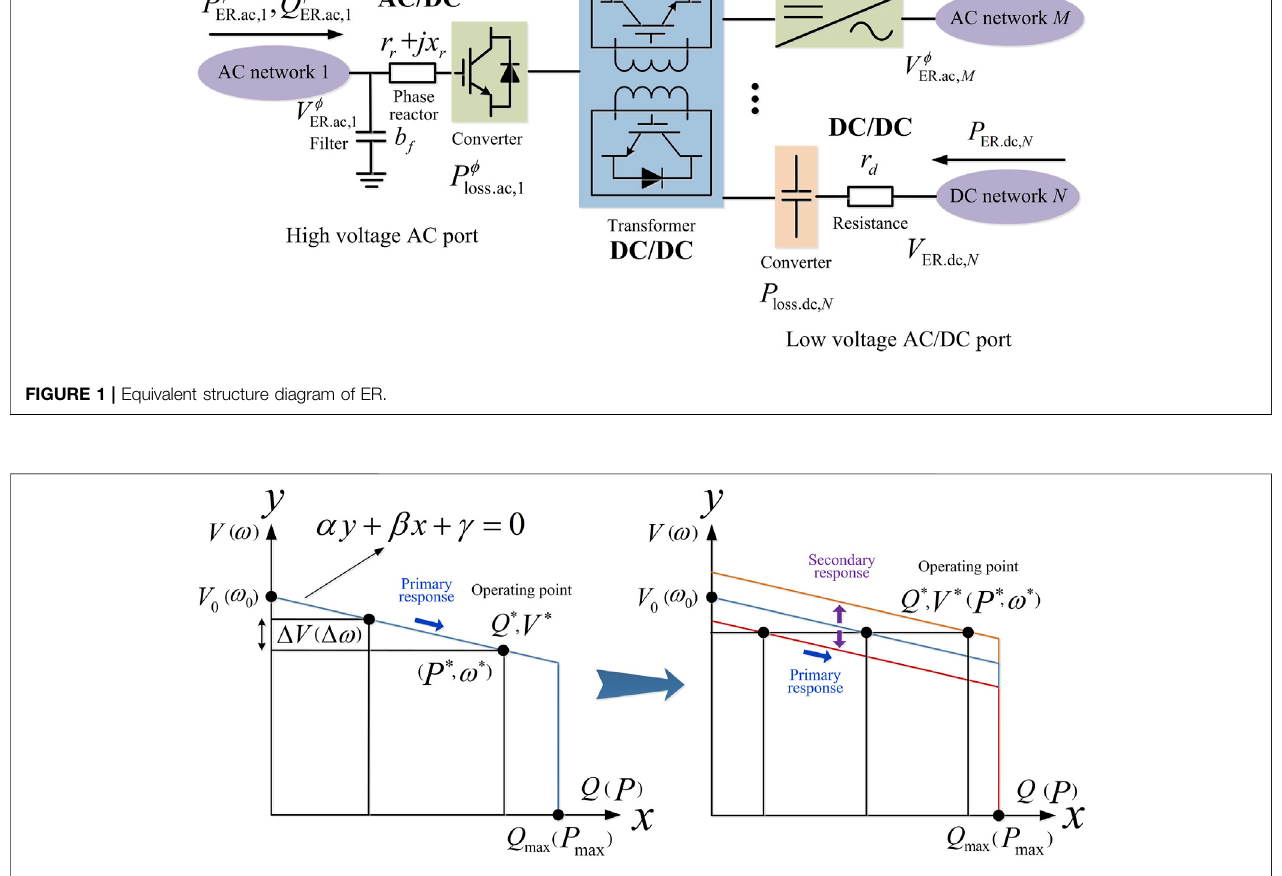
FIGURE 2 | Secondary coordinated control